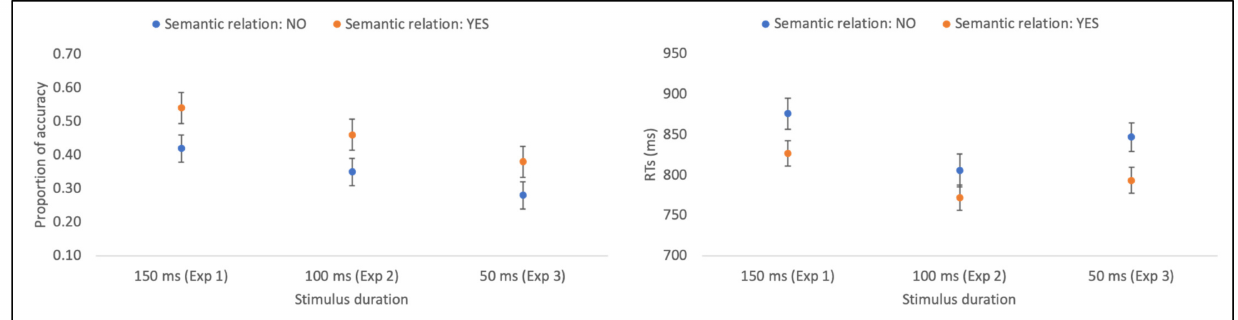
Figure 6. Summary of results in terms of accuracy and response times in case of presence or absence of semantic relation between W1 and W2. Bars represent standard